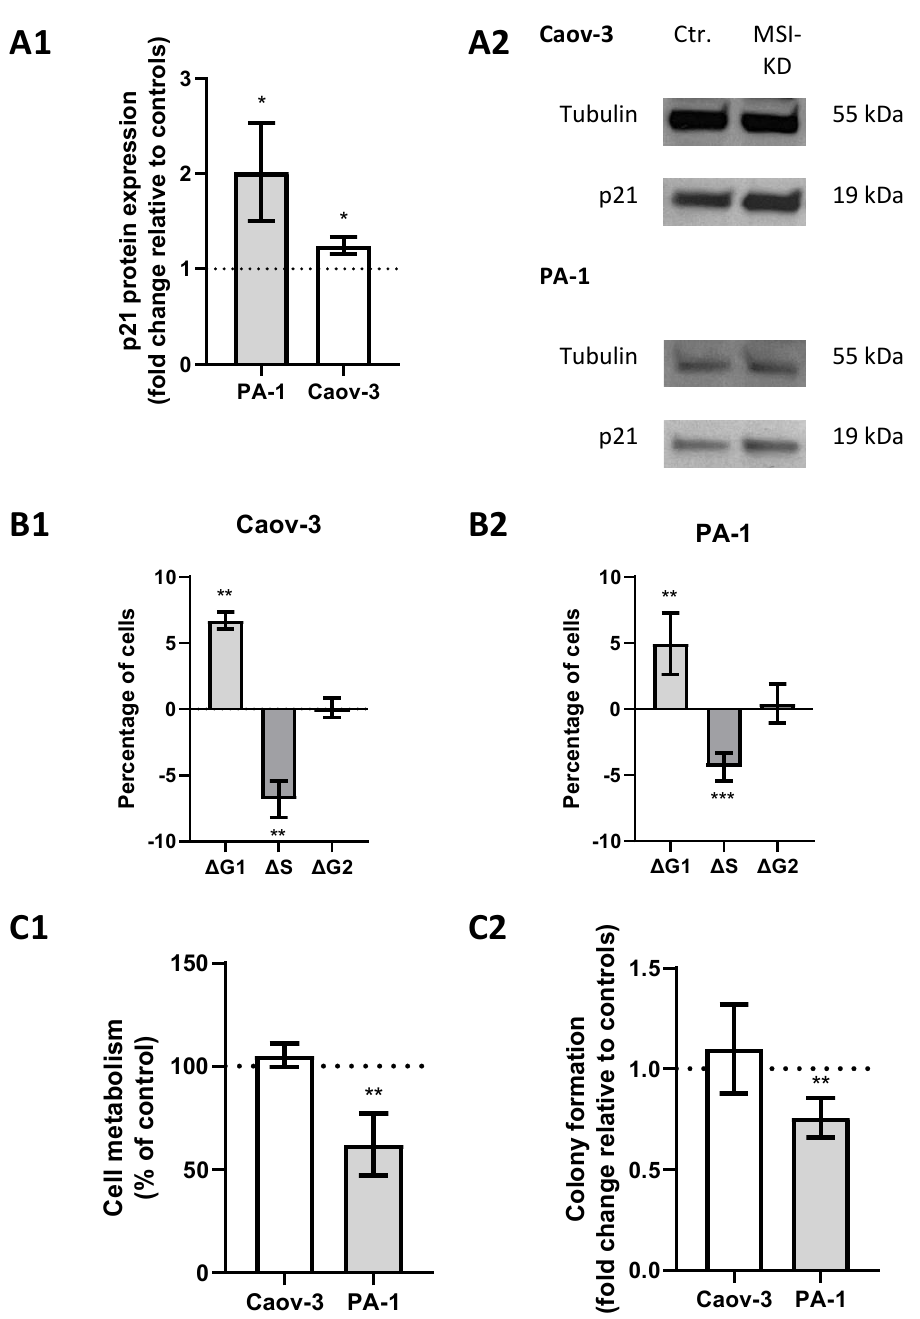
Figure 4. Musashi-mediated changes regarding cell cycle regulation. ( A1 ): p21 is upregulated after Musashi dual inhibition in both cell lines with representative images in panel ( A2 ). ( B1 , B2 ): Cells are more likely to be in the G1 phase and less likely to be in the S phase after Musashi dual inhibition in both cell lines. ( C1 , C2 ): Cell metabolism and colony formation are decreased in PA-1 cells, while no changes are seen in Caov-3 cells after Musashi dual inhibition. All experiments were repeated at least three times in duplicates. p values < 0.05 were deemed significant (* p < 0.05; ** p < 0.01; error bars indicate standard error of the mean